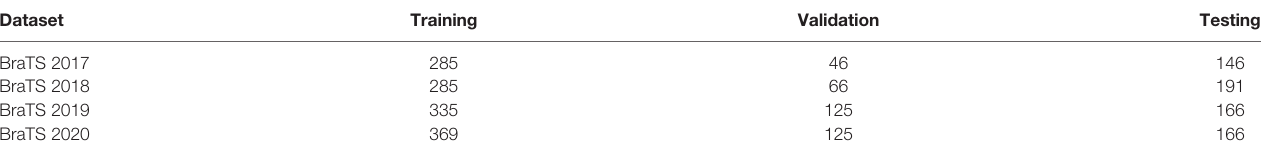
TABLE 2 | Summary of the BraTS challenge dataset from 2017 to 2020.